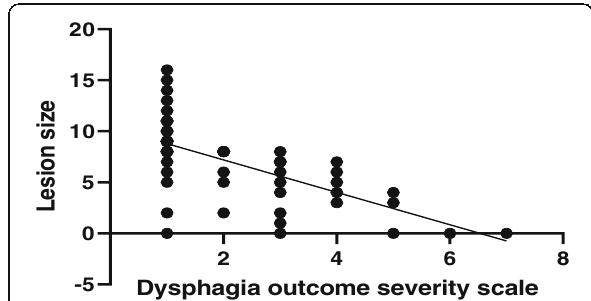
Fig. 2 Correlation between dysphagia outcome severity scale and lesion size, significant negative correlation between severity of dysphagia and stroke size, r = 0.774 , P <